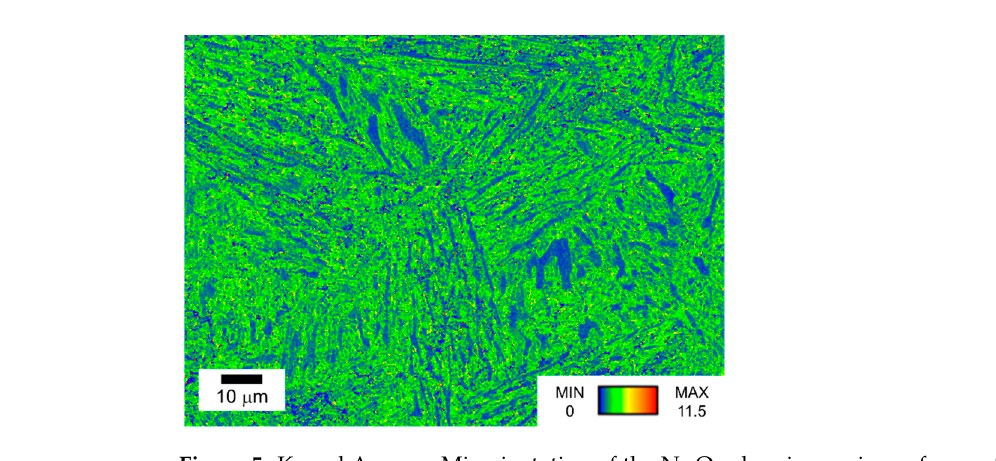
Figure 4. Reconstruction results depicting austenite grains and their orientations for ( a ) N H Q L , ( b ) N L Q L , ( c ) N H Q H , ( d ) N L Q H samples. The austenite regions in ( a ) indicated by yellow arrows have KS variants in common with the surrounding austenite region, to within 5° misorientation.